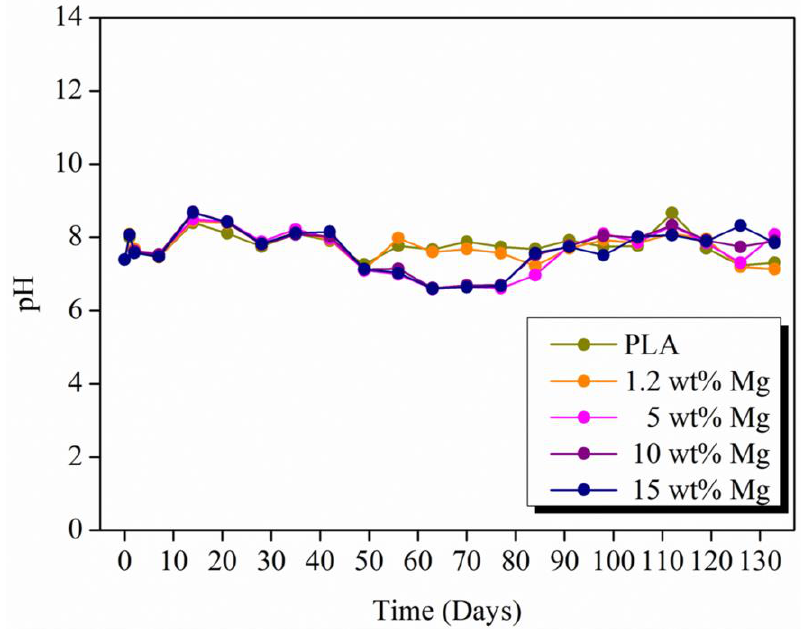
Figure 12. Evolution of pH values for each PLA-Mg filament during degradation in PBS media.